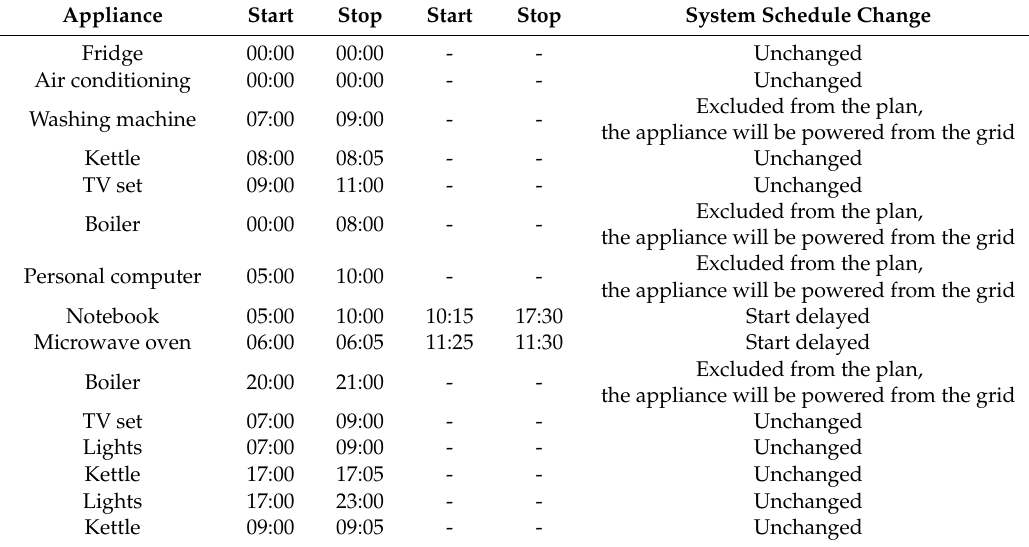
Table 10. The example appliance plan after the Active Demand Side Management (ADSM) optimization achieved in the experiment.